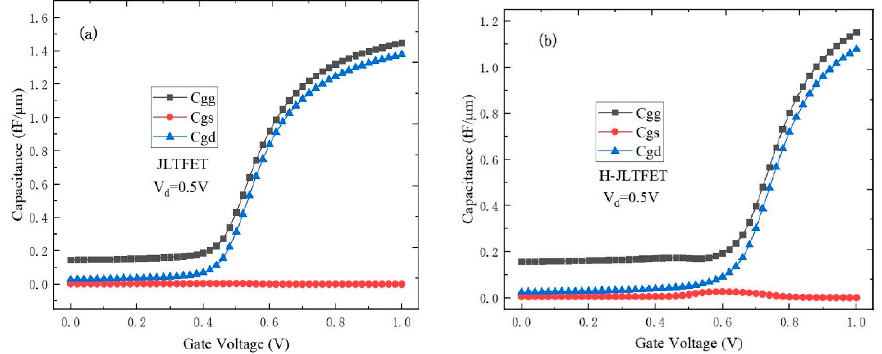
Figure 9. Capacitance characteristics of ( a ) JLTFET; and ( b ) H-JLTFET.